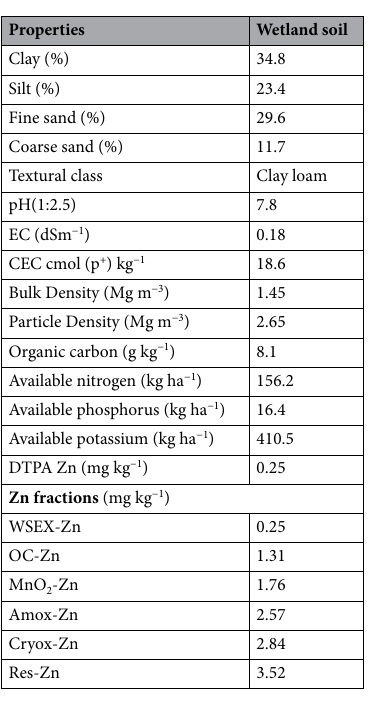
Table 2. Initial characteristics of the experimental soils.